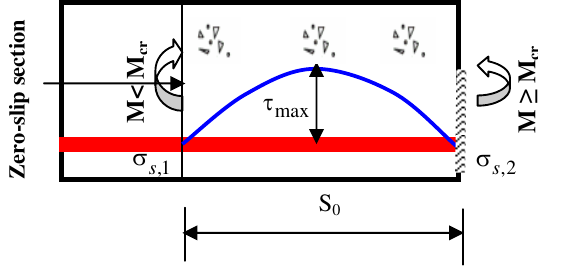
Fig. 4. Bond stress near cracked